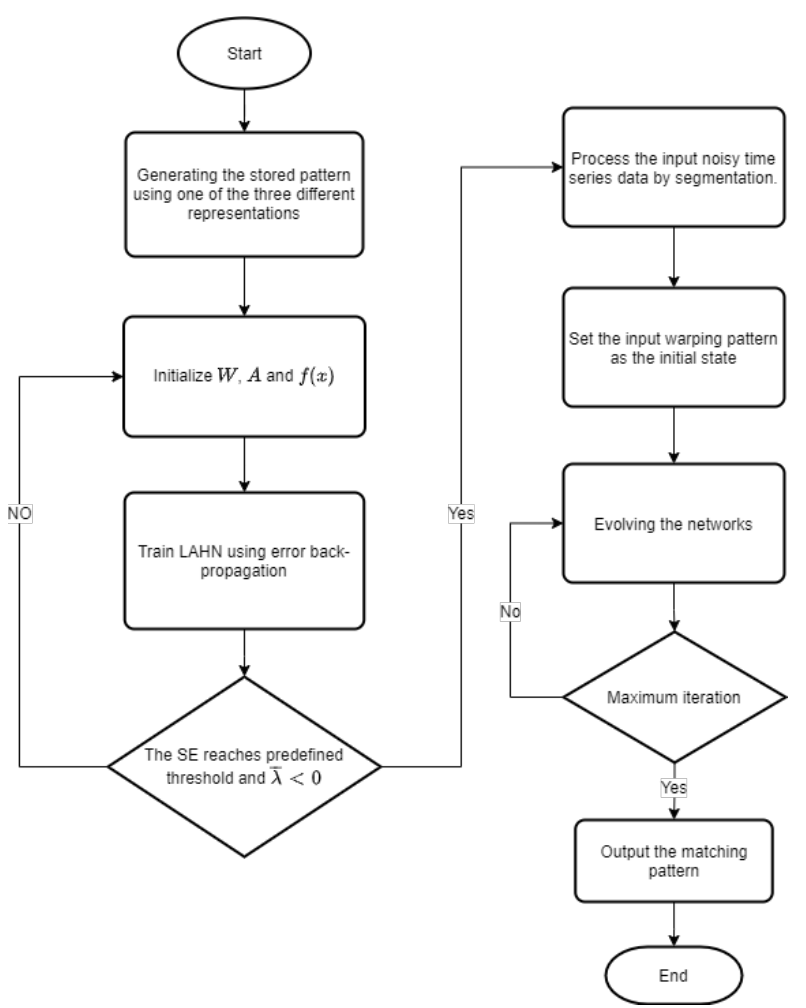
Figure 8. The training process and pattern matching process of